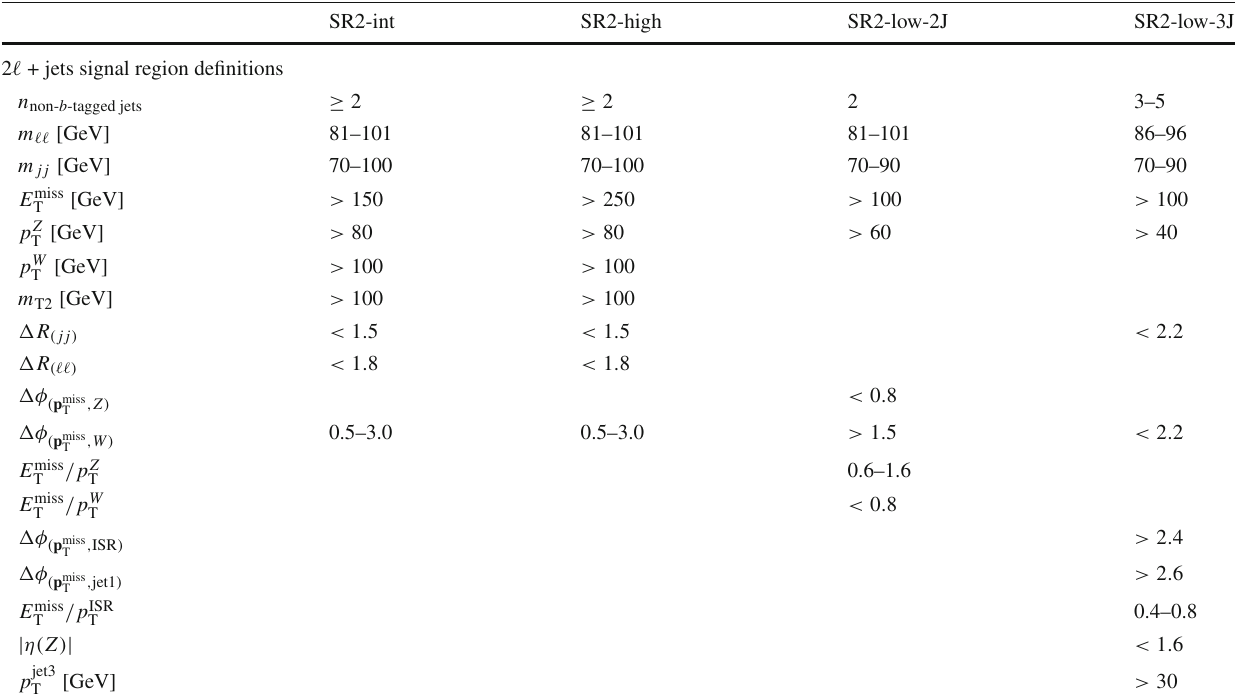
Table 2 Signal region definitions used for the 2 (cid:4) + jets channel. Rele- vant kinematic variables are defined in the text. The symbols W and Z correspond to the reconstructed W and Z bosons in the final state. The Z boson is always reconstructed from the two leptons, whereas the W boson is reconstructed from the two jets leading in p T for SR2-int, SR2- high and the 2-jets channel of SR2-low, whilst for the 3–5 jets channel of SR2-low it is reconstructed from the two jets which are closest in